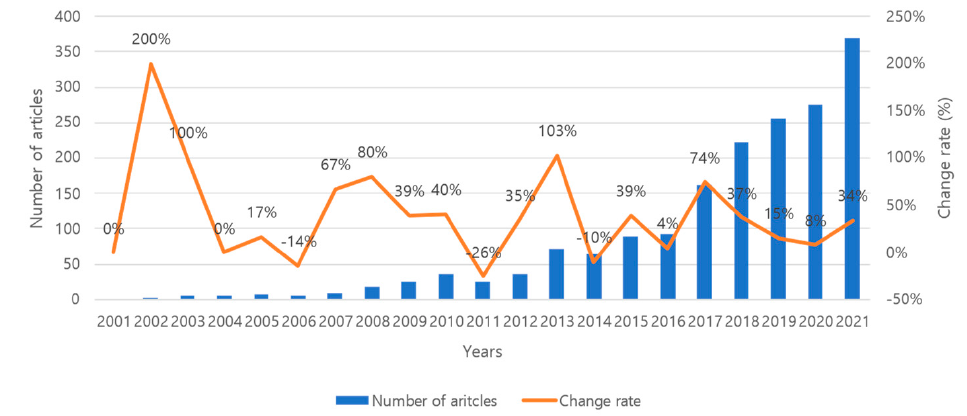
Figure 3. The yearly numbers of articles published from 2001 to 2021.